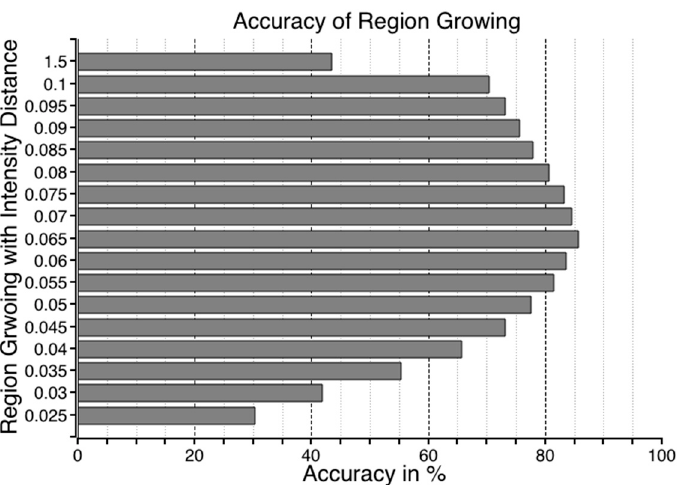
Figure 8. RegGro accuracy. The accuracy was determined according to the ground truth. Each horizontal bar shows the accuracy with a different intensity distance, ranging from 0.025 (RegGro_025) to 0.15 (RegGto_150). The highest accuracy was 85.7% with an intensity distance of 0.065.